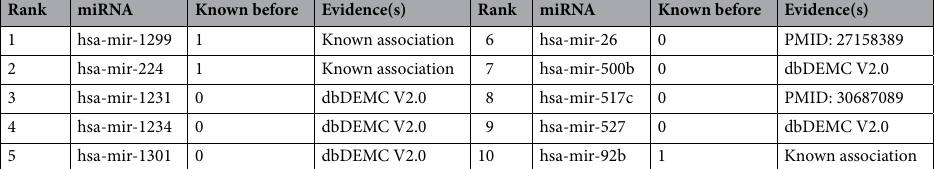
Table 7. Top 10 predicted ovarian neoplasms-associated miRNAs in the simulated experiment for predicting new disease-related miRNAs.